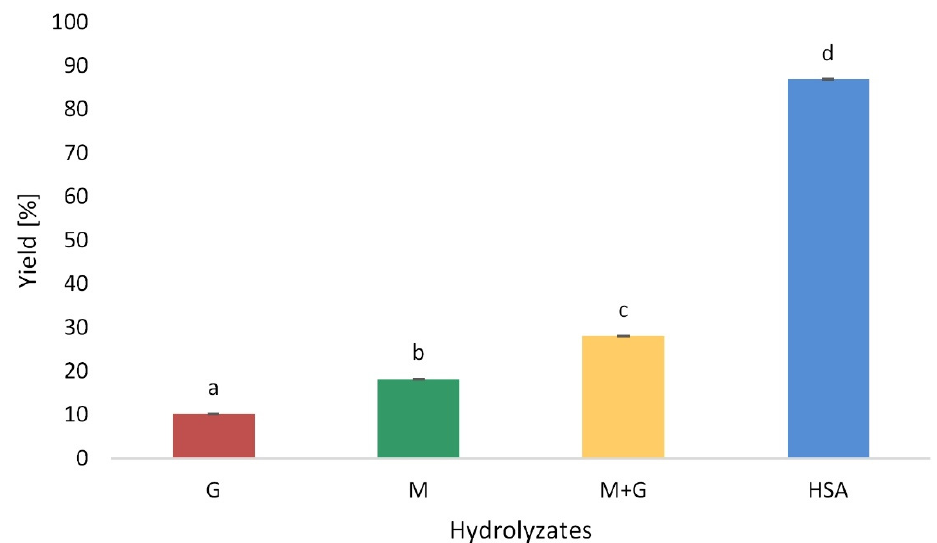
Figure 1. Hydrolysis yield of acidic (G, M and M + G) and oxidation (HSA) depolymerization products of sodium alginate. Results are expressed as the mean ± standard error. Values with different letters ( a – d ) within the same column differ significantly ( p < 0.05).